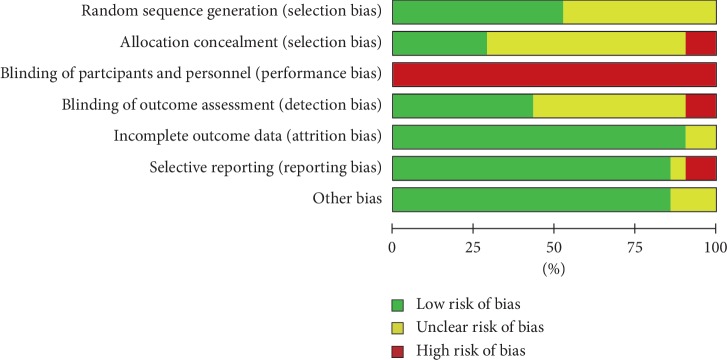
Risk of bias graph.